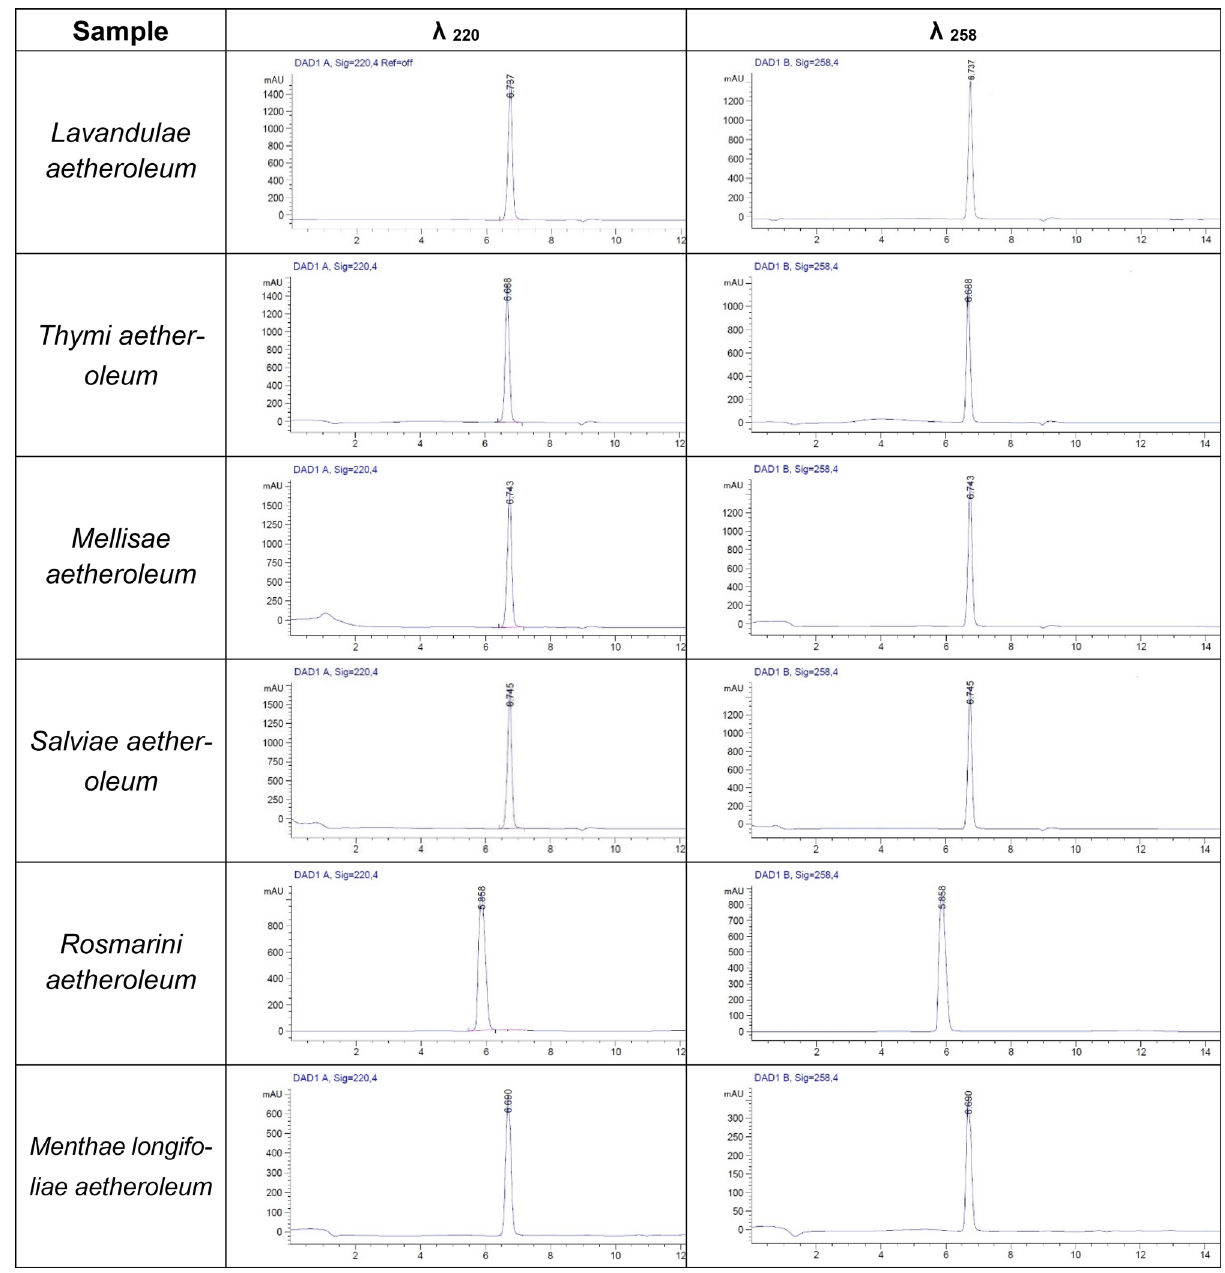
Table 2. The chromatograms of the reaction mixtures of cysteine peptide and essential